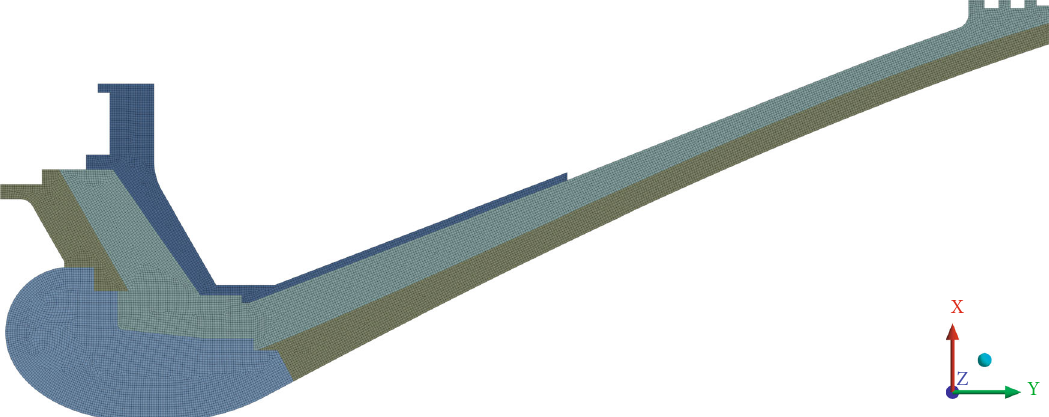
Figure 11: Mesh generation of the thermo-structural